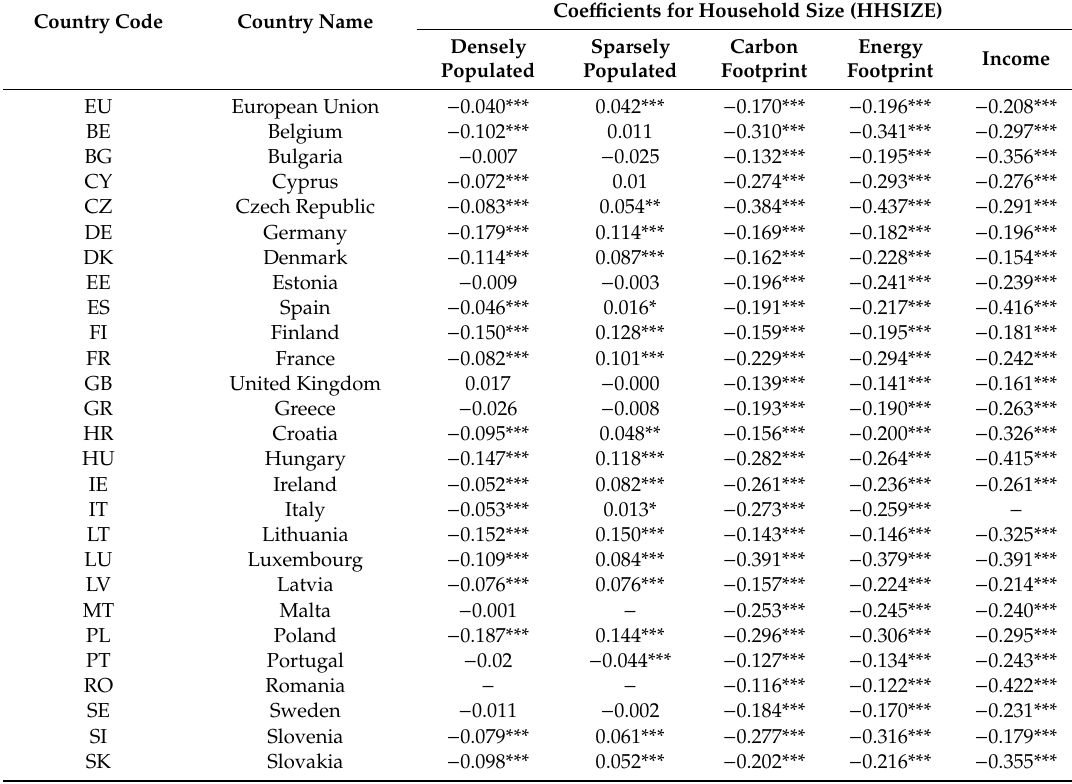
Table 1. Standardized bi-variate regression coe ffi cients (can be interpreted as pairwise correlation coe ffi cients) between household size and other variables by EU